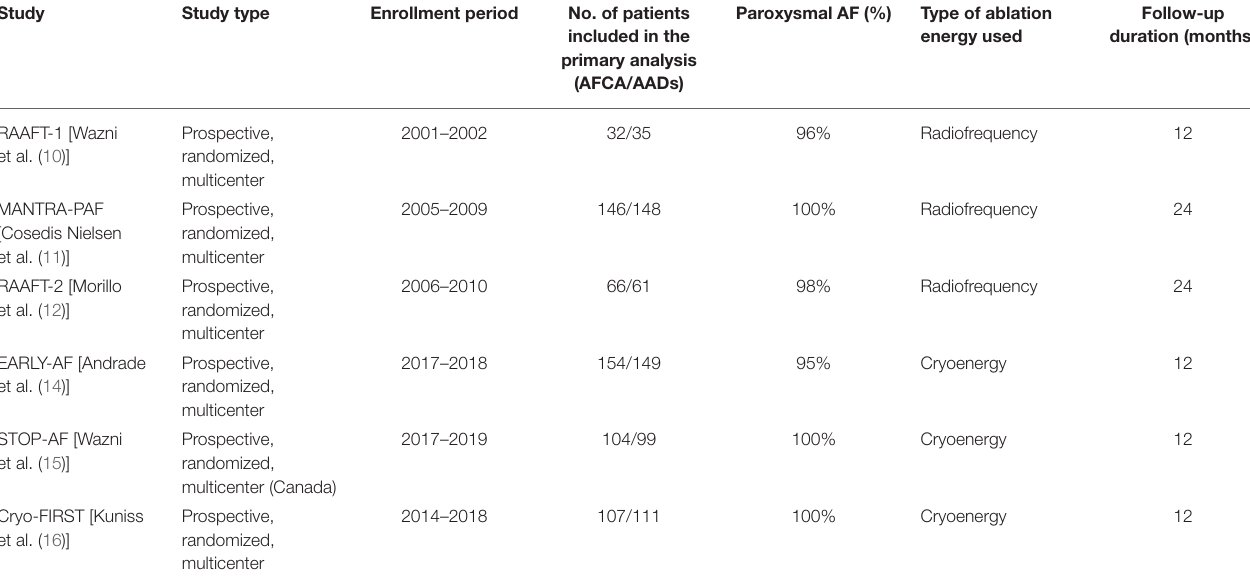
TABLE 1 | Main characteristics of the included randomized clinical trials comparing first-line catheter ablation with antiarrhythmic drugs in symptomatic atrial fibrillation. Study